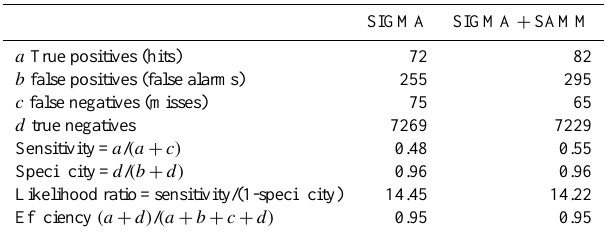
Table 6. Validation statistics of the landslide warning system with (SAMM + SIGMA) and without (SIGMA) the contribution of the snow accumulation melting